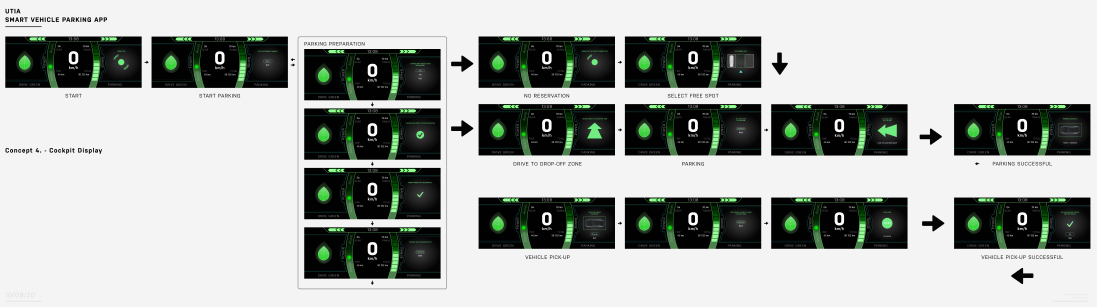
Figure 6. Vehicle cockpit human–machine